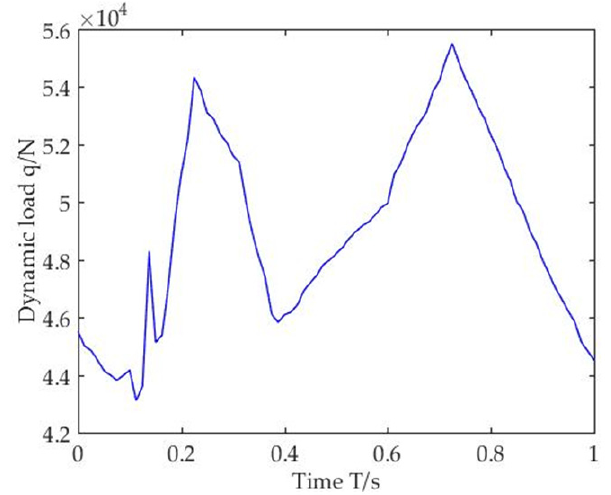
Figure 3. Vehicle tire dynamic load.